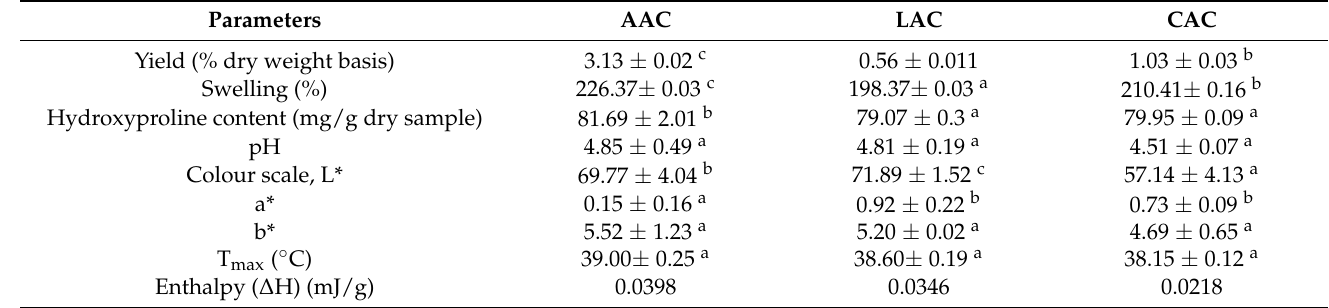
Table 2. Extraction yield and physicochemical properties of acid-soluble collagen from the skin of needlefish ( Tylosurus acus melanotus ) extracted using different acid extraction